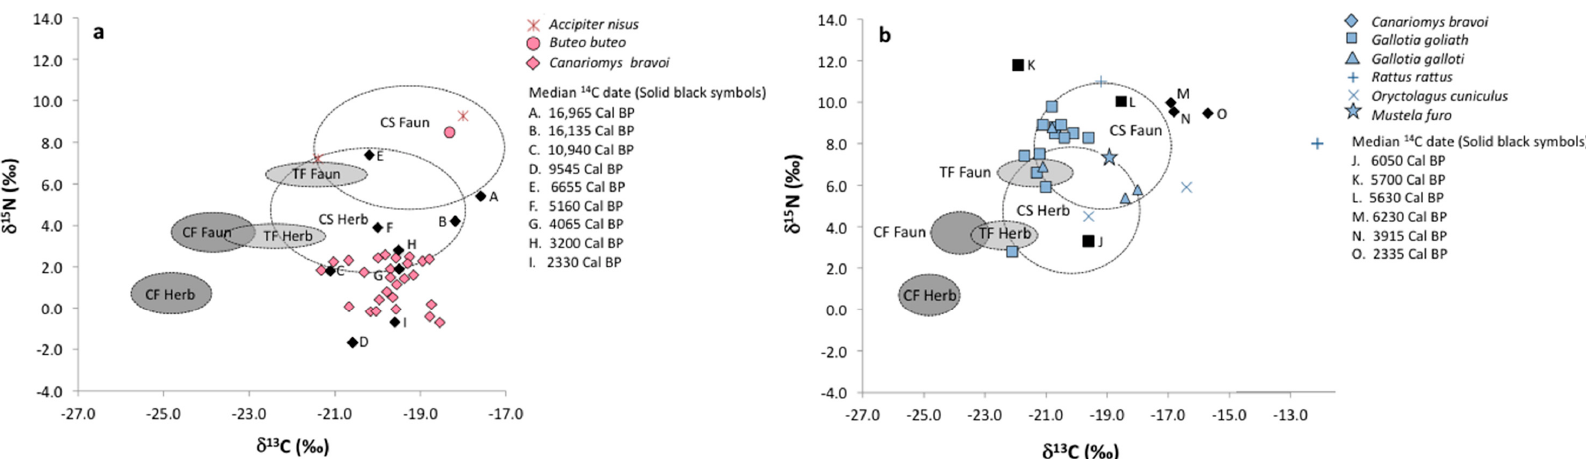
Figure 5. Summary carbon and nitrogen isotope data for taxa from ( a ) Icod and ( b ) Buenavista del Norte. Expected δ 13 C and δ 15 N values (mean ± 1 σ for herbivores (Herb) and faunivores (Faun) living in coastal scrub (CS), thermophilous forest (TF), and cloud forest (CF) are provided in bubbles (see Data Analysis section and Table S2). Radiocarbon-dated individuals are indicated with solid symbols. See Table 2 for date sources.